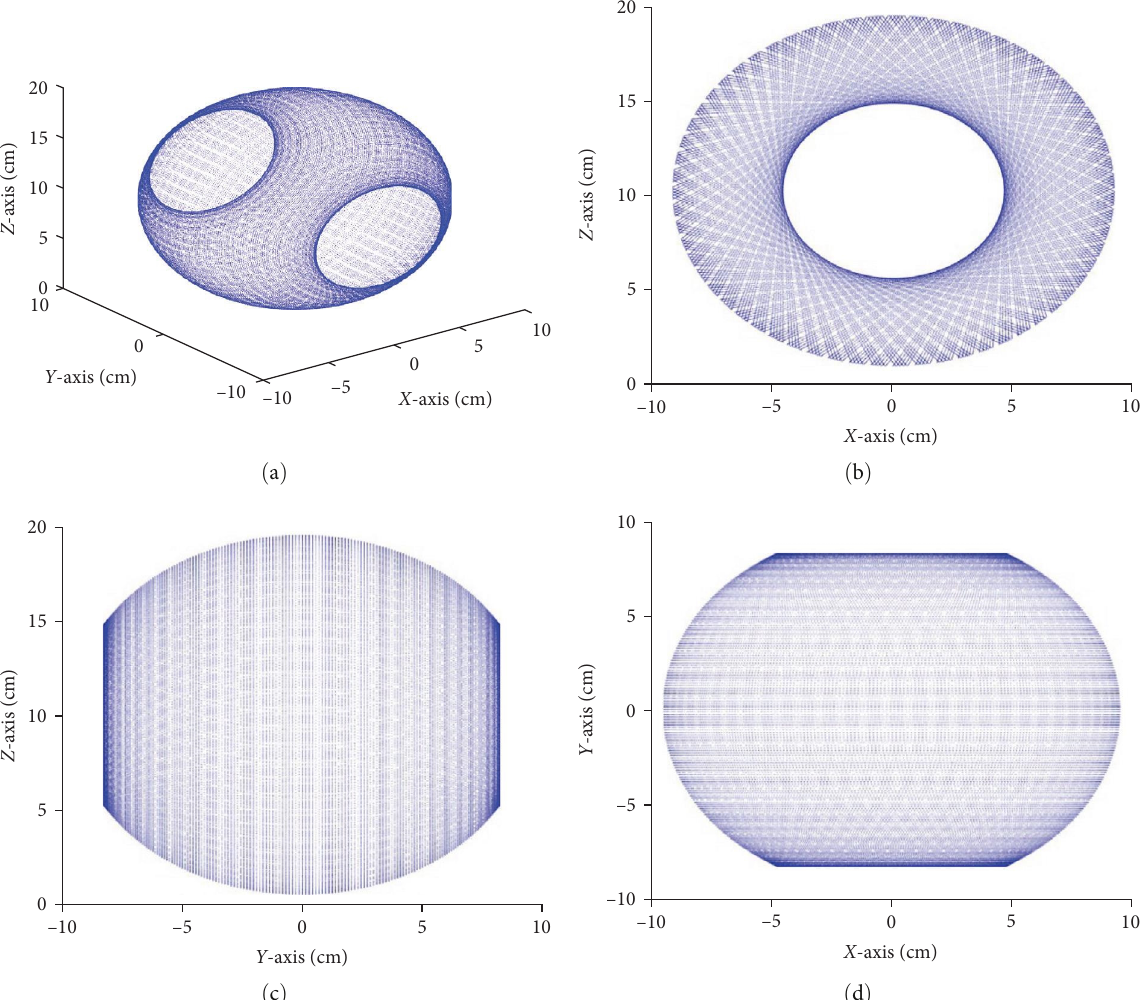
F IGURE 10: The workspace analysis of the FWM. (a) The Cartesian 3D space. (b) X – Z -axis of 2D space. (c) Y – Z -axis of 2D space. (d) X – Y -axis of 2D space.